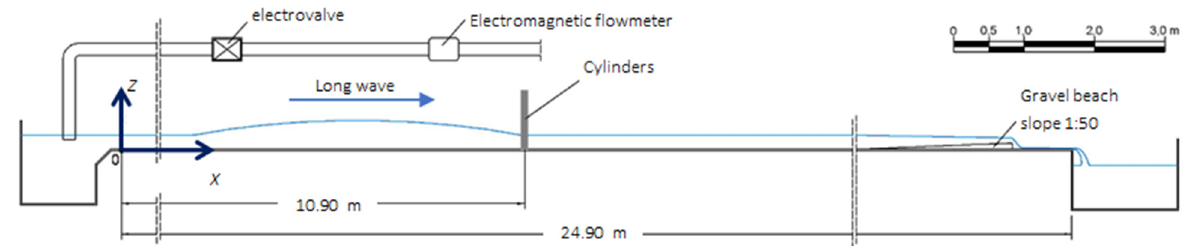
Figure 1. Sketch of the channel with location of the cylinders and ( X,Z ) axes. Side view.